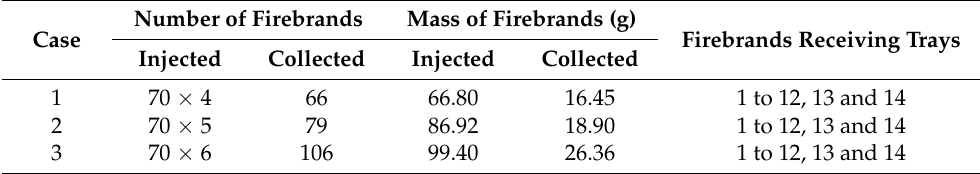
Figure 8. Snapshots of Douglas fir tree burning and firebrand distribution at: ( a ) zero seconds; ( b ) 14 s; ( c ) 21 s; ( d ) 35 s. The arrow in ( c ) shows some firebrands moving upwards with the convective column during the intensive burning before landing on the floor. Table 6. Mass received by trays injecting a different number of Table 5. Number, velocity, and direction of firebrand variations to obtain matching collection.